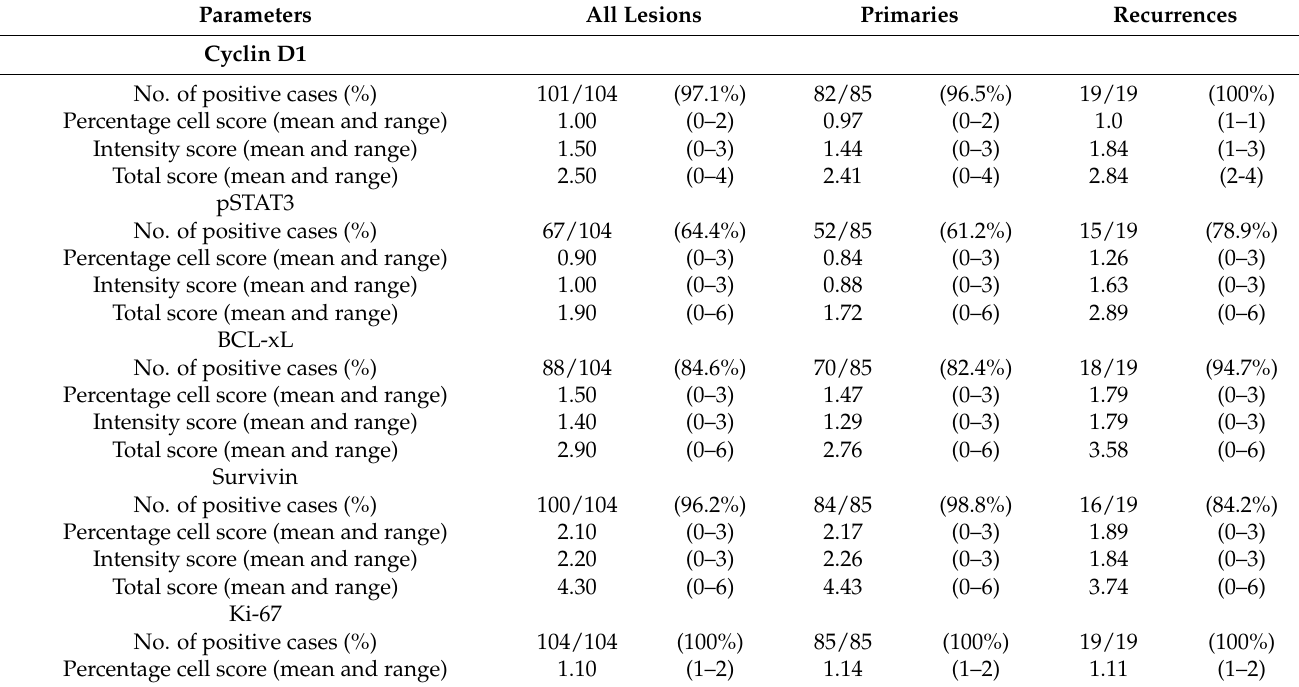
Table 3. Synopsis of immunohistochemical results for the various studied molecules in oral leukoplakia (OL) lesions, including primary lesions and